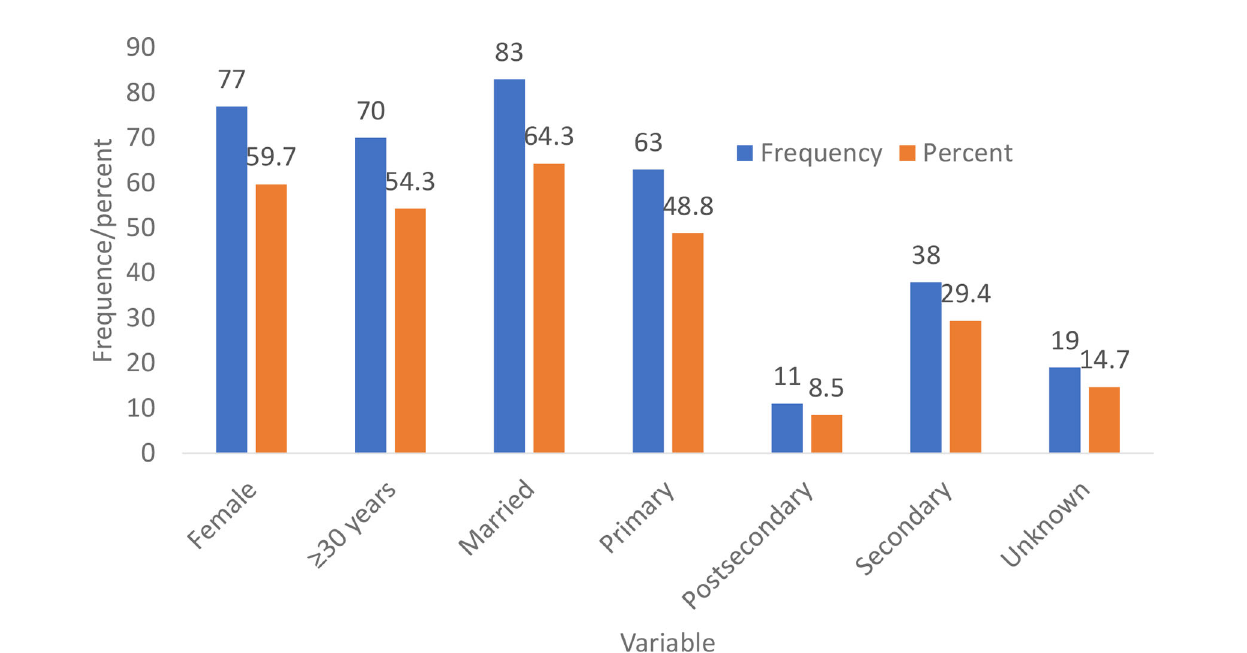
FIGURE 4 | Demographic characteristics of the participants who were eligible for treatment indication using the TREAT-B score ≥ 2.0 from both the low and high endemic